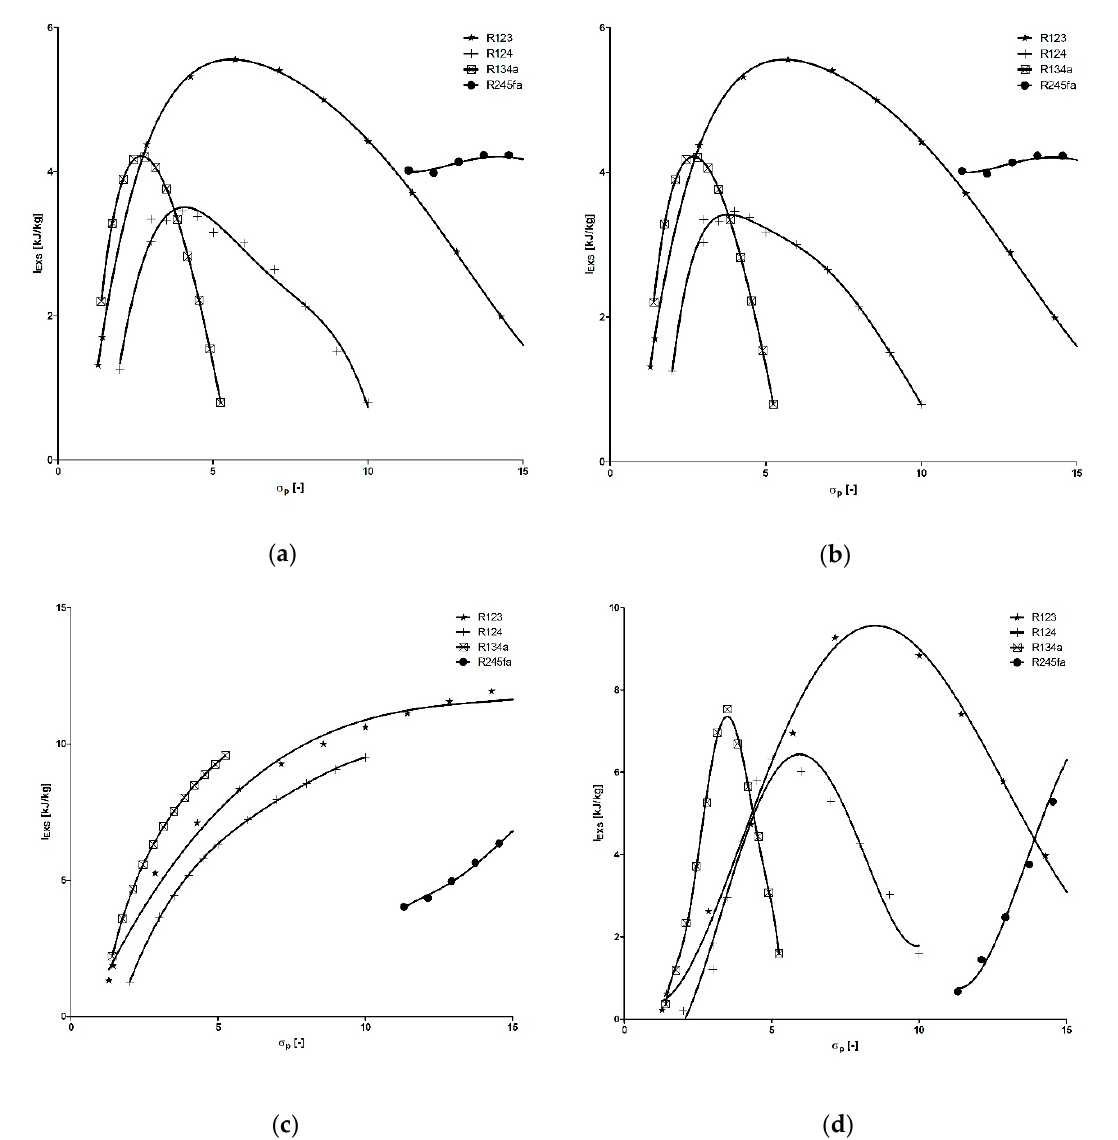
Figure 8. The variation of isentropic expansion work vs. pressure expansion ratio: ( a ) graph valid for the heat source histogram presented in Figure 5a; ( b ) graph valid for the heat source histogram presented in Figure 5b; ( c ) graph valid for heat source histogram presented in Figure 5c; ( d ) graph valid for the heat source histogram presented in Figure 5d.